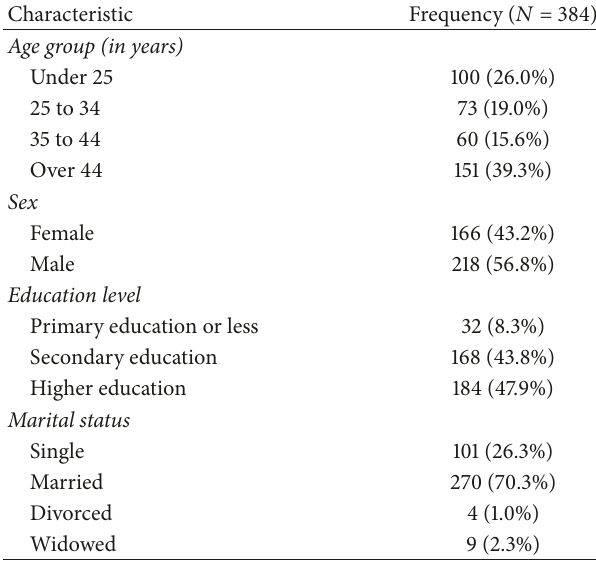
Table 1: Demographic characteristics of the study